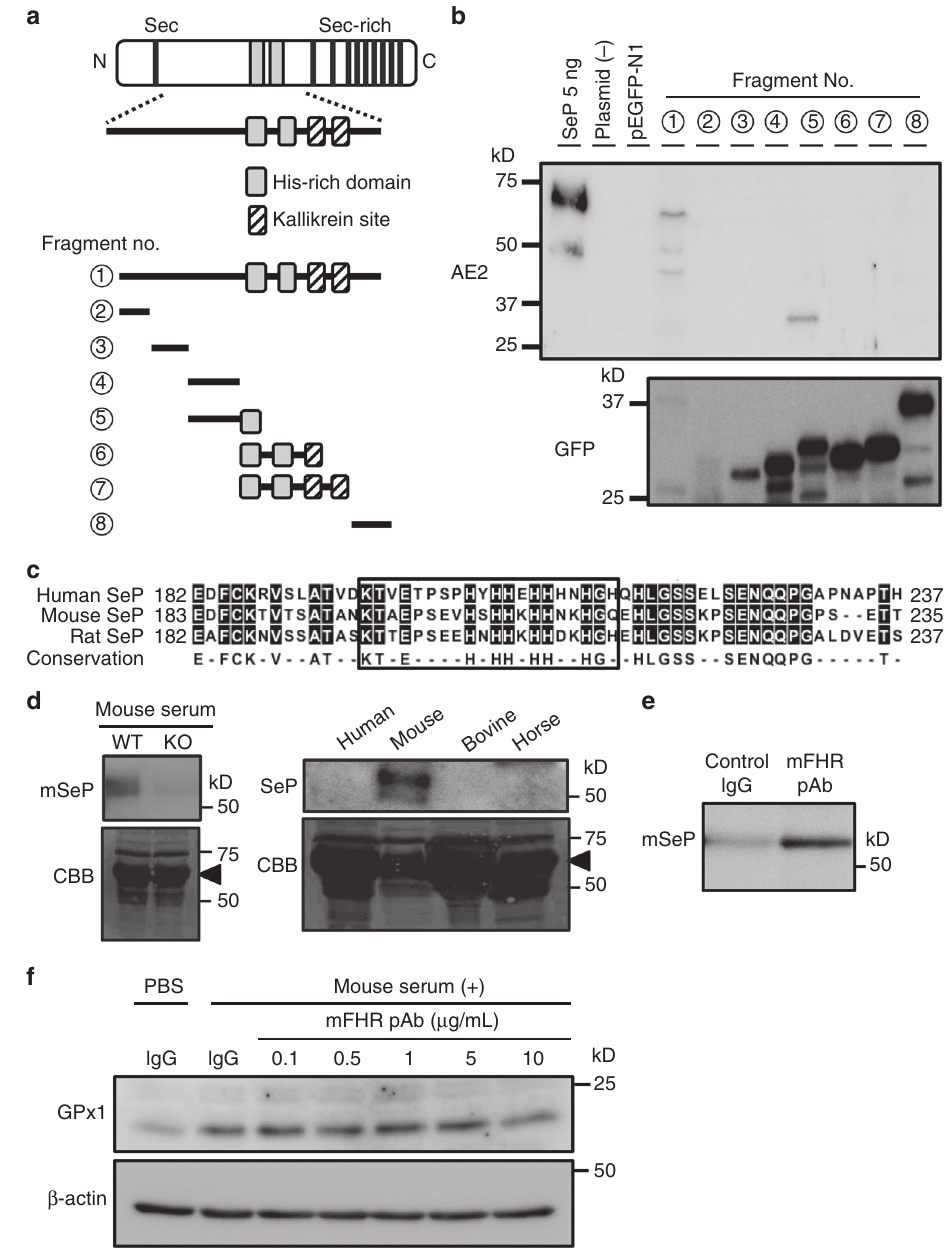
Fig. 6 The identi fi cation of epitope recognized by SeP-neutralizing Abs. a Schematic outline of the epitope mapping approach. Green fl uorescence protein (GFP)-tagged deletion constructs of hSeP were prepared. b Identi fi cation of AE2 mAb recognition site. Whole-cell lysates transfected GFP-tagged deletion constructs of hSeP were analysed by western blotting using anti-hSeP Ab AE2 and anti-GFP Ab. c Amino acid sequence homology around the fi rst histidine-rich region (FHR) between three species. Predicted epitope of neutralizing antibody is enclosed. d Speci fi city and cross-reactivity of prepared polyclonal antibody for the FHR of mouse SeP (mFHR). Serum from wild type and SeP-KO mouse and other animal species was analysed by western blotting using mFHR pAb. As a loading control, separated proteins were stained with Coomassie Brilliant Blue R-250 (CBB). The major band derived from albumin is indicated. e Immunoprecipitation of mSeP by mFHR pAb. Mouse SeP in mouse serum was reacted with mFHR pAb- or control IgG-conjugated beads 4 °C for 2 h, and then immunoprecipitants were analysed by western blotting using mFHR pAb. f Evaluation of mFHR pAb against Se-supply activity by mSeP in C2C12 myocytes. Cells were treated with mouse serum (1%) in the presence of the indicated amount of mFHR pAb or control rabbit IgG (10 µ g/mL) for 24 h. GPx1 levels were determined by western